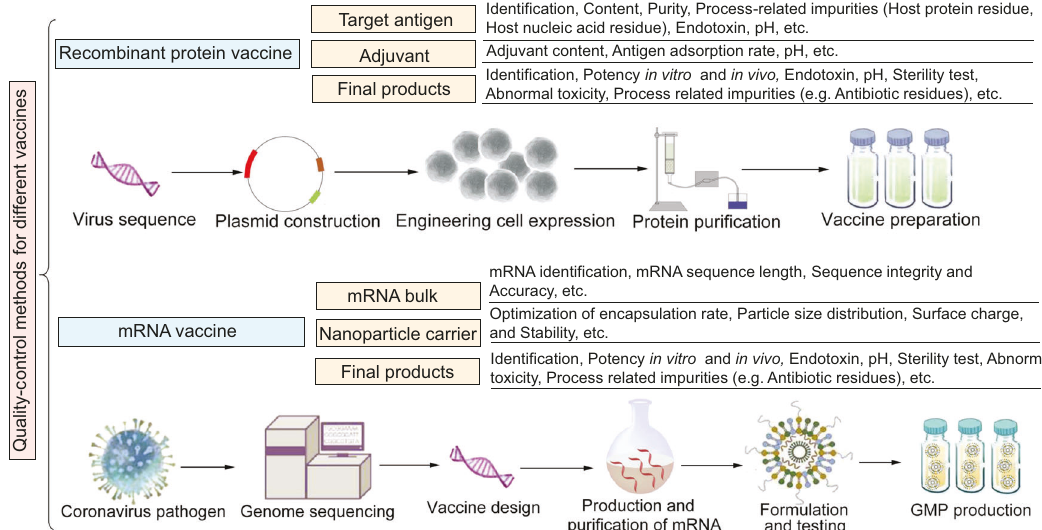
Fig. 1 Key points of quality control for COVID-19 vaccines developed by different platforms. Note: the main quality control items are listed in the fi